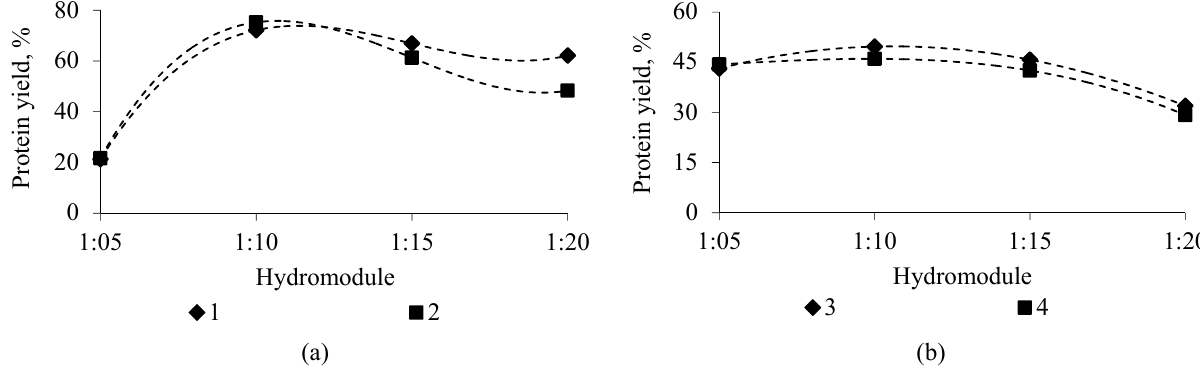
Fig. 7. Effect of the amount of hydromodule in the process of alkaline (a) and acid (b) extraction on the yield of protein substances from the oat grains of the Rysak variety in the presence of: (1) 1 M of a potassium hydroxide solution; (2) 1 M of a sodium hydroxide solution; (3) of an aqueous hydrochloric acid solution; (4) of an aqueous sulfuric acid solution.